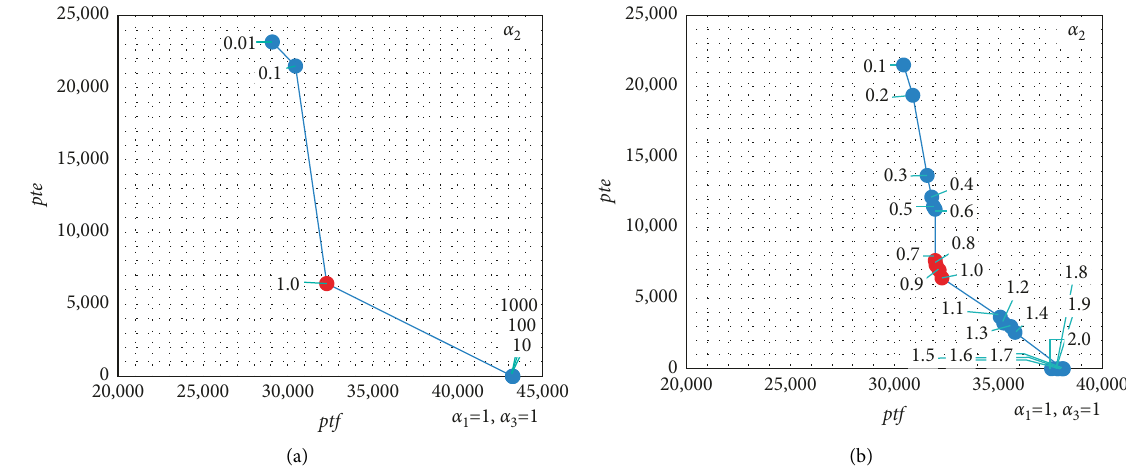
Figure 9: Pareto curve of results with different values of α